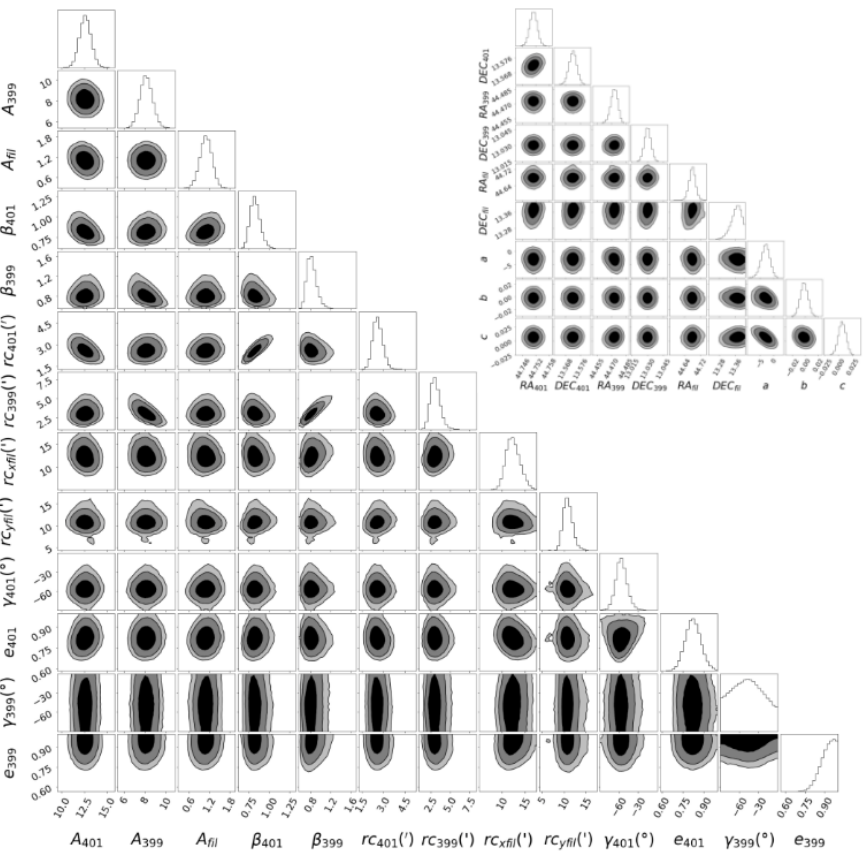
Figure 2. Bottom Left : Posterior distributions for 13 of the 22 parameters that describe the ’2 Elliptical β -profiles + mesa ’ model. Top Right : Posterior distributions for the remaining parameters. Contours levels describe the Gaussian confidence levels at 1, 2, and 3 σ .